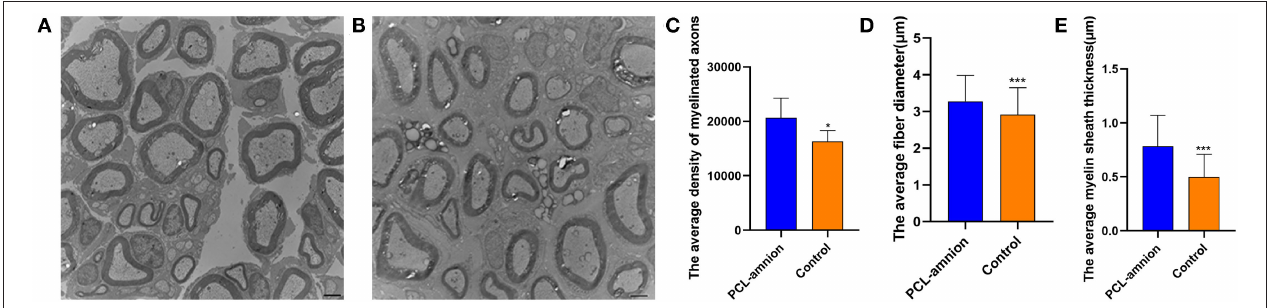
FIGURE 8 | Transmission electron microscopy images of the nerve tissues at 16 weeks. (A) The PCL-amnion nanofibrous membrane group. (B) The Control group. (C) The average density of myelinated axons was significantly different between two groups ( P < 0.05). (D) The average fiber diameter of myelinated nerve fibers was significantly different between two groups ( P < 0.05). (E) The average myelin sheath thickness of the sciatic nerve was significantly different between two groups ( P < 0.05). * P < 0.05 compared to the PCL-amnion group. *** P < 0.001 compared to the PCL-amnion